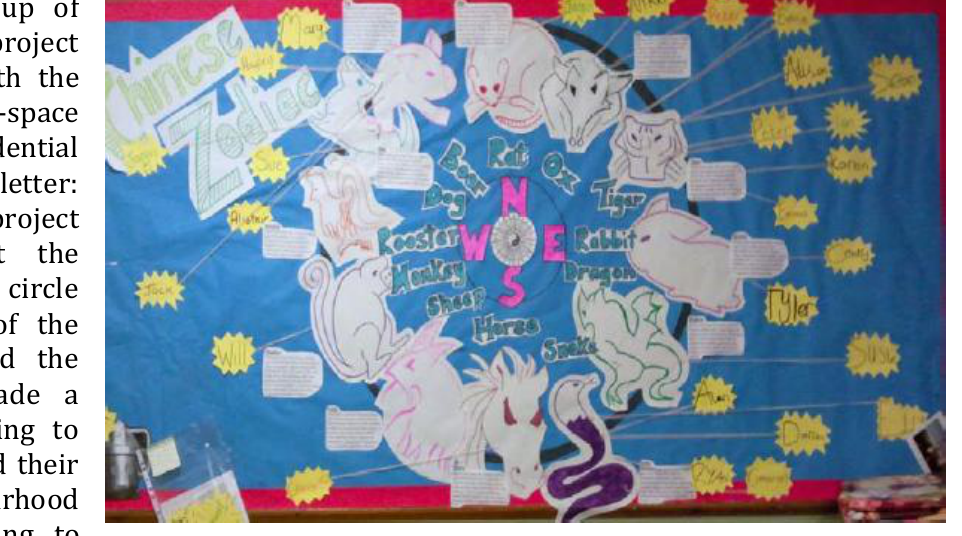
Figure 2: The Chinese Zodiac wall at a children’s